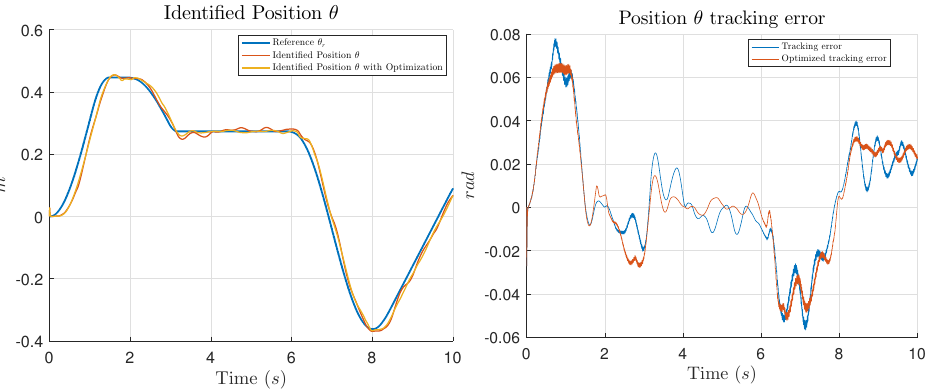
Figure 11. Tracking of θ ( left ) and error comparison ( right ) for the experimental test